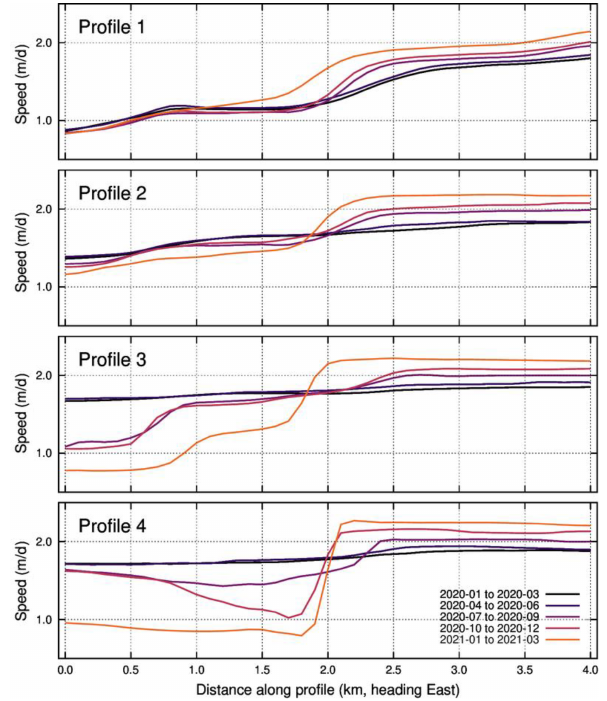
Figure 5. Profiles of mean quarterly surface velocity during 2020 and 2021 from Sentinel-1 speckle/feature tracking along the white lines shown in Fig.